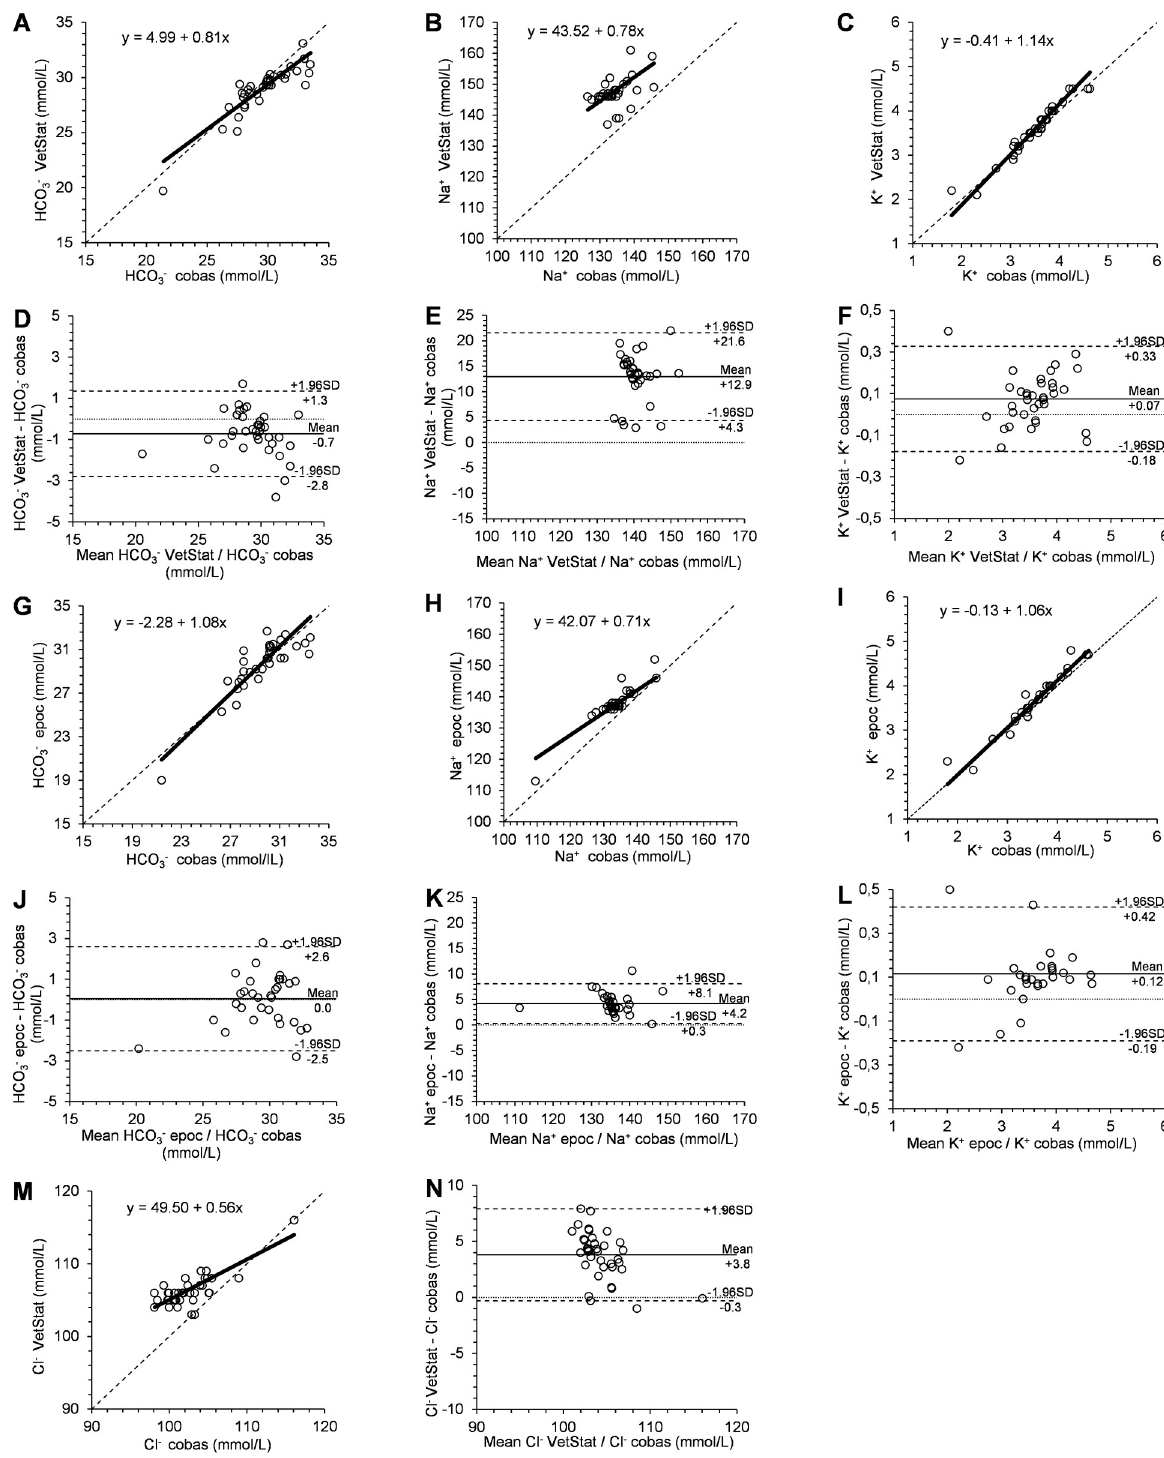
Fig 2. Passing-Bablok regression analysis and Bland-Altman plot analysis for comparison of different analyzers for blood [HCO3-], [Na + ], [K + ] and [Cl - ]. Passing-Bablok regression analysis for comparison of VetStat versus the cobas b 123 analyzer for blood [HCO 3- ] (A), [Na + ] (B), [K + ] (C), and [Na + ] (M), and for comparison of epoc versus cobas b 123 analyzer for blood [HCO 3- ] (G), [Na + ] (H) and [K + ] (I). The dashed line is the line of identity, the solid line is the best fit. Bland-Altman plot for comparison of VetStat versus cobas b 123 analyzer for blood [HCO 3- ] (D), [Na + ] (E), [K + ] (F) and [Cl - ] (N) and for comparison of epoc versus cobas b 123 analyzer for blood [HCO 3- ] (J), [Na + ] (K), and [K + ] (L). The dashed lines are upper and lower limit of agreement, the solid line is the mean difference (bias).